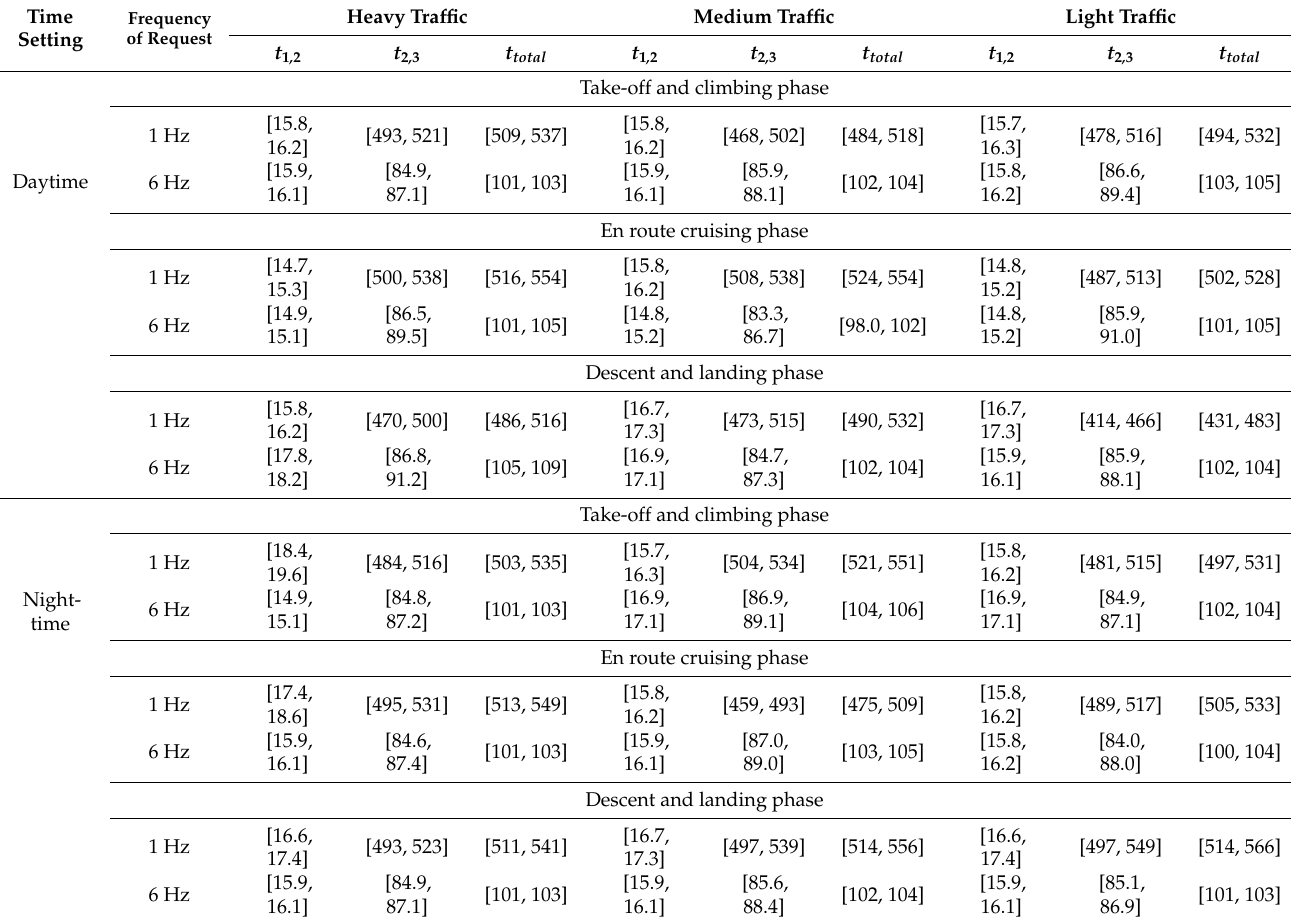
Table 4. Descriptive statistics of the system latency performance 1